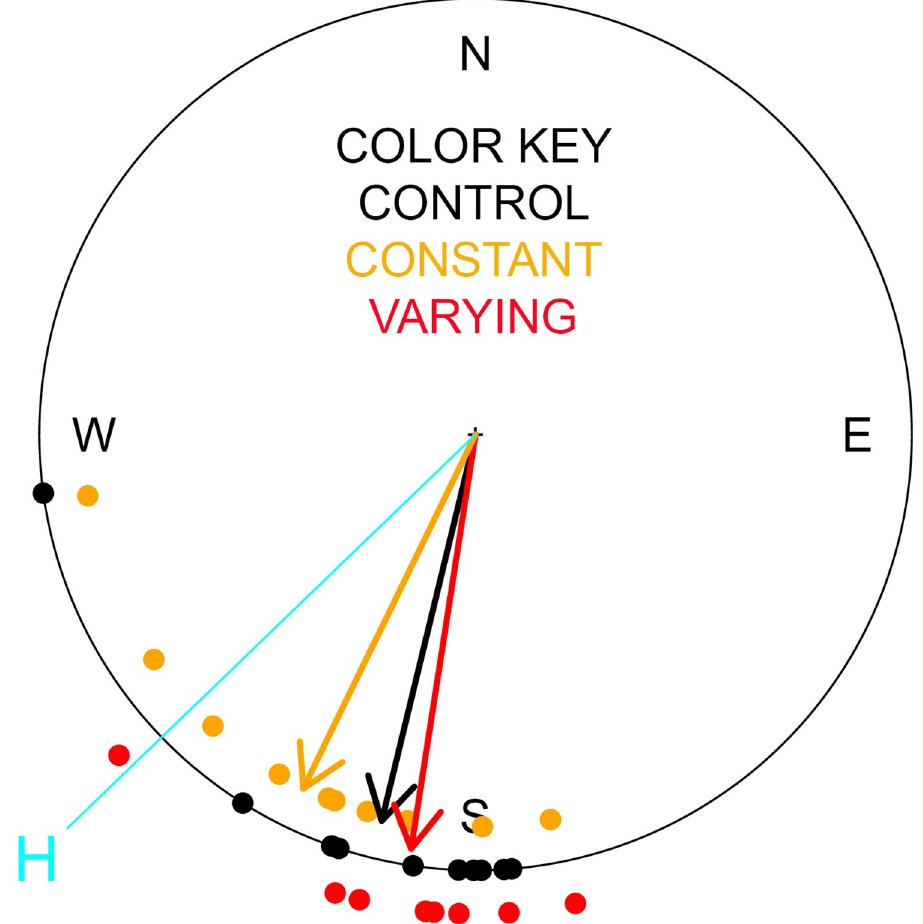
Fig 2. Vanishing bearings of pigeons from the second release along with the mean vector for each group. Black = control; Orange = exposed to constant magnetic field in MRI; Red = exposed to varying magnetic field from scanning sequences. Home direction is marked with the light blue line and